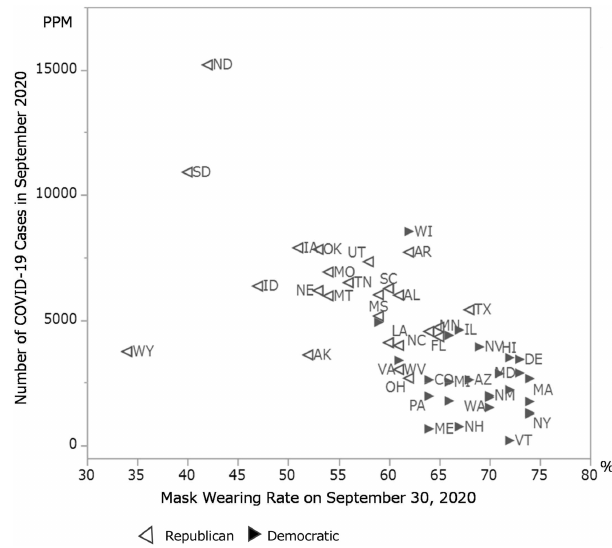
Figure 3, with the states labeled with the party they supported in the 2020 presidential election. The states in which self-responsibility is highly valued were likely to have supported the Republican Party and that valuation may have influenced the way the residents think about wearing a mask. Schoeni et al. (2021) showed that both the rate of not wearing a mask in the past week and the adjusted percentage of at-risk adults never wearing a mask were higher for Republicans than Democrats. Also, Green et al. (2020) showed that Democratic members of